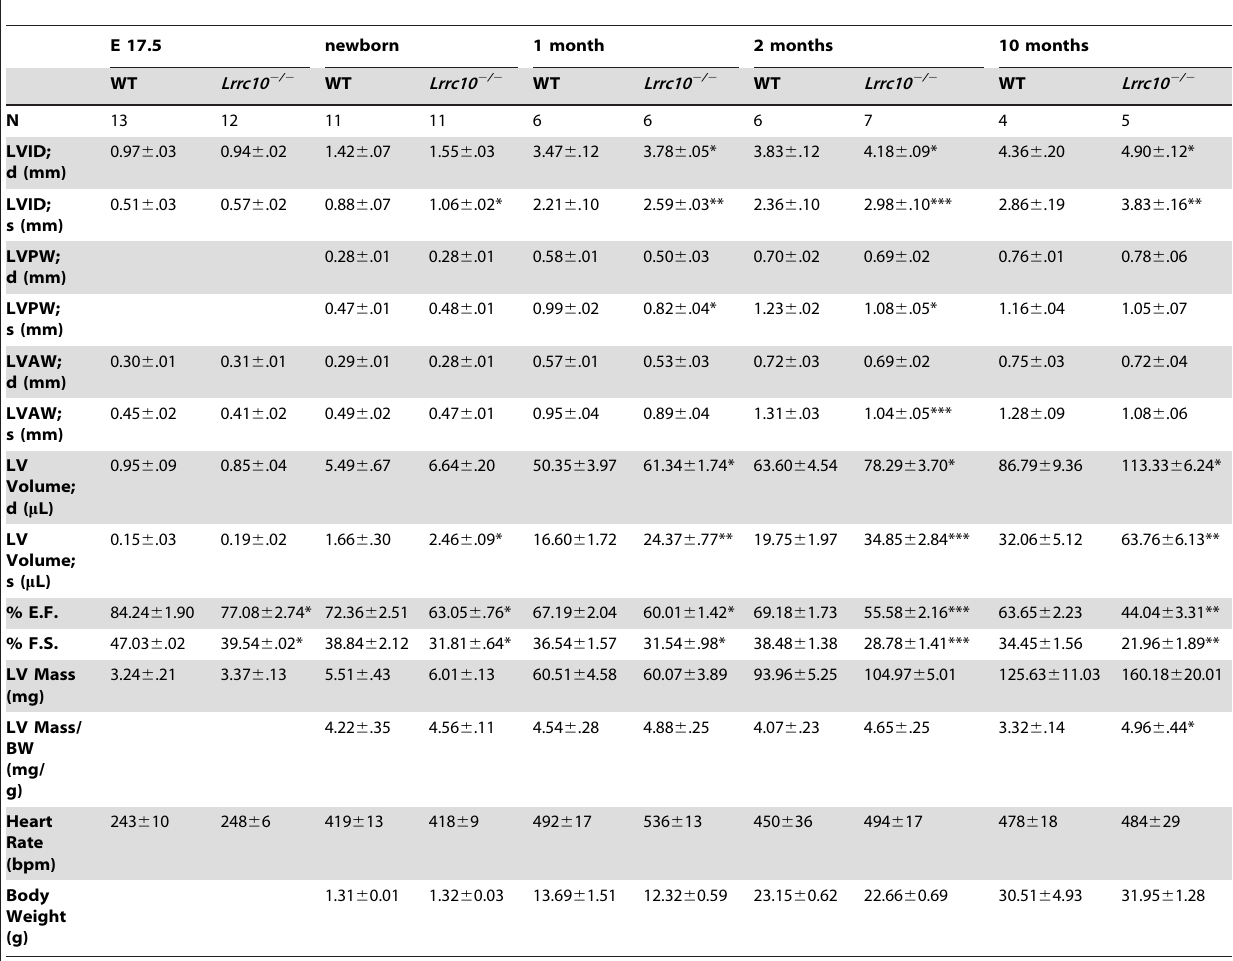
Table 1. Echocardiographic assessment of cardiac structure and function in Lrrc10 2 / 2